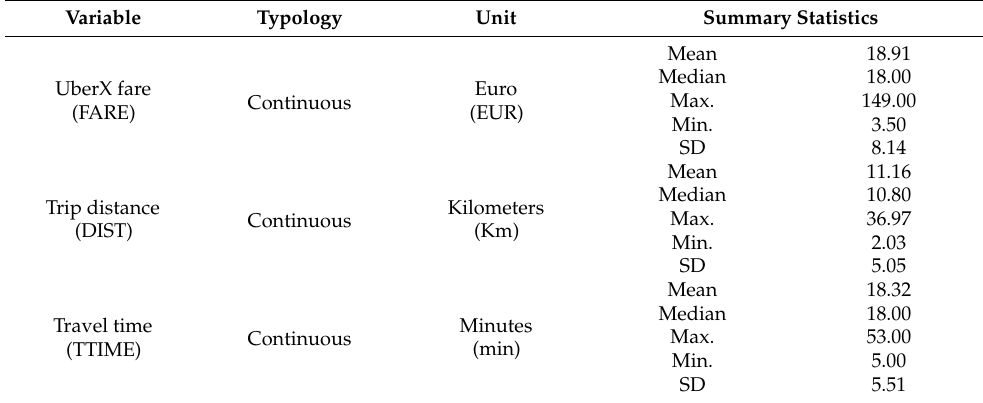
Table 2. Summary statistics of explanatory